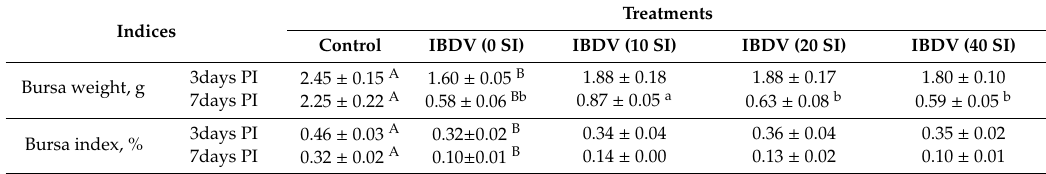
Table 4. E ff ect of adding soy isoflavones on bursa development of IBDV-challenged broilers 1 .